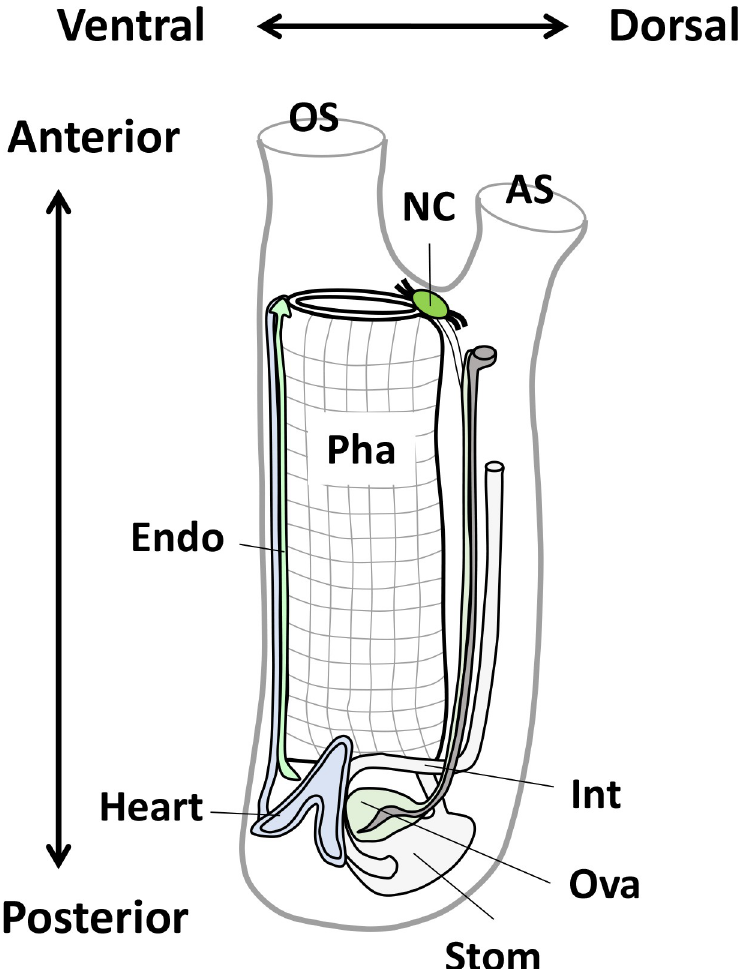
Fig 1. Schematic illustration of the body structure of an adult ascidian. The illustration was modified from Osugi et al., 2020 [12]. The key anatomical parts of the 9 tissues analyzed in this study are indicated. AS, atrial siphon; Endo, endostyle; Int, intestine; NC, neural complex; OS, oral siphon; Ova, ovary; Pha, pharynx; Stom, stomach. listed in Table 1. The expression level for each gene was calculated as RPKM (reads per kilo- base per million total reads) and is listed in S1 Table with raw read numbers. A previous microarray analysis identified TSGs based on the ratio of the median expression values between a specific organ and others (cutoff values ranging 1.3–9.4) [27]. Such median-based identification includes specifically expressed genes in individual and multiple tissues (e.g., brain- and intestine-specific genes). To define tissue specificity more strictly, we identified TSGs based on the RPKM (RPKM > 1 in an individual tissue and RPKM < 0.5 in all other tis- sues, i.e., all TSGs show more than 2-fold higher expression than any other tissues) (Tables 1 and S2). The RNA-seq data reproduced some of the specific expression patterns of the previ- ously identified TSGs in the neural complex, endostyle, heart, ovary, stomach, and intestine (S1 Fig) [27], confirming the reliability of the RNA-seq data and their usefulness for the follow- ing analyses. The greatest number of TSGs was identified in the intestine (312 genes) and the least was in the pharynx (15 genes) (Table 1). Amino acid sequences for the identified TSGs in Ciona were subjected to BLASTP analysis against the RefSeq protein database for mice and